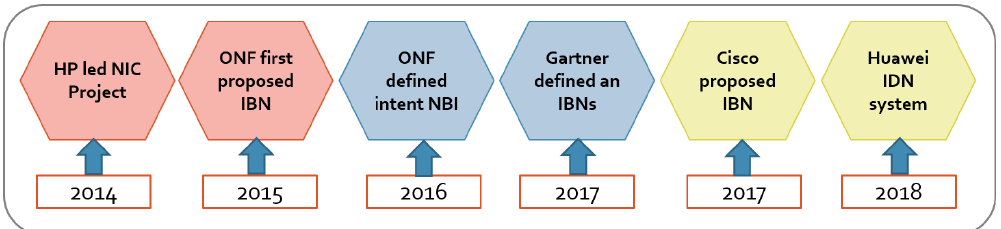
Figure 2. IBN system development